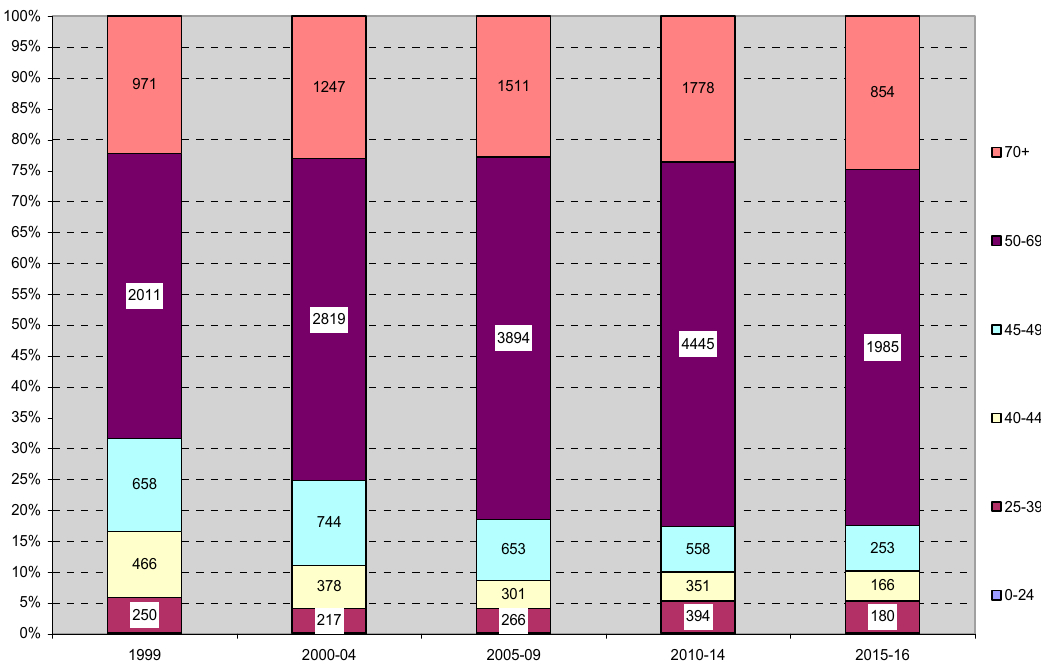
Figure 1. Age structure and number of malignant neoplasms of breast cases for selected age groups and periods.